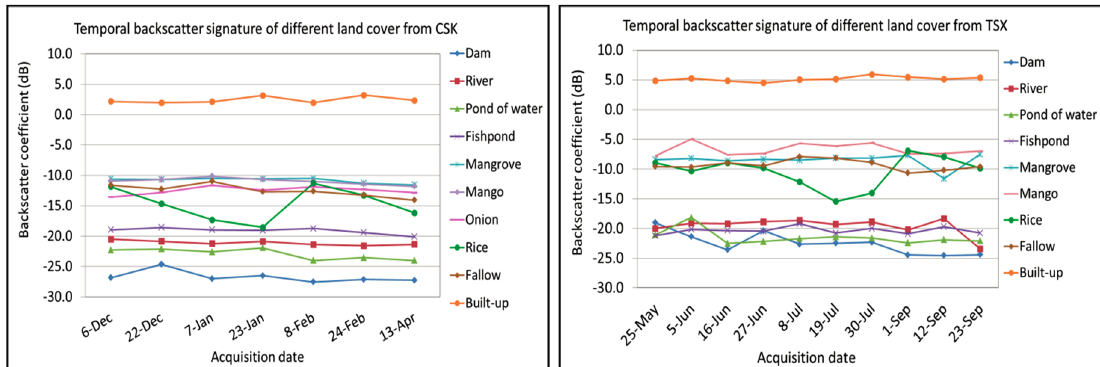
Figure 3. Example of a temporal backscatter signature from different land covers derived from CSK ( left ) and TSX ( right